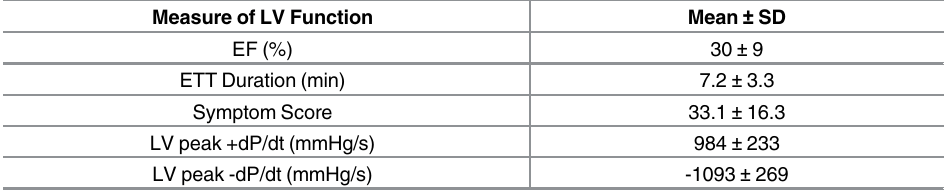
Table 2. Mean Values of Key Measures of LV Function (n = 56).